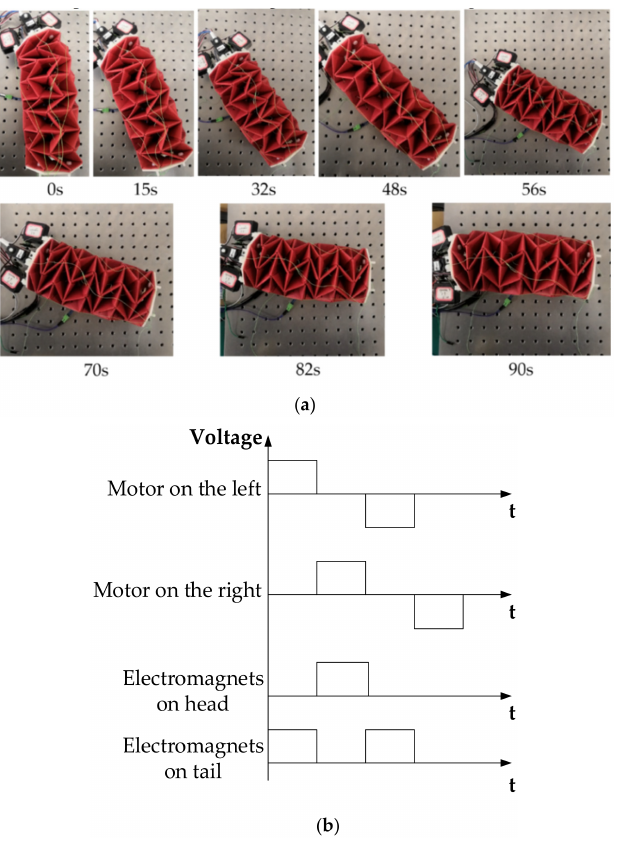
Figure 25. Origami crawling robot with electromagnetic sliding feet on an iron plane: ( a ) top view of left-turning motion; ( b ) control signals of motors and electromagnets of left-turning